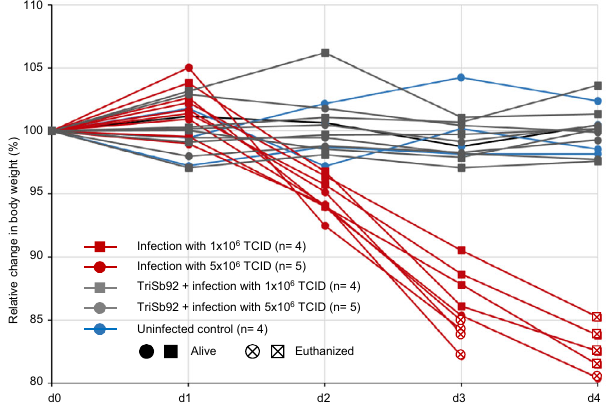
Fig. 5 | TriSb92can protect froma lethal challenge withmouse-adaptedSARS- CoV-2. Body weight development of Balb/c mice that were infected with 1×10 6 or 5×10 6 PFU of the pathogenic SARS-CoV-2 strain maVie16 following intranasal administration TriSb92 (25 μ g of per nostril; red lines and symbols) or the same volume of saline buffer (grey lines and symbols) 1h earlier, as indicated. Four control mice received similar mock treatment but no TriSb92 or virus (blue lines and symbols). The experiment was terminated at day 4 post-infection when all infected mice that had not received TriSb92 prophylaxis had been euthanized because of losing 15% or more of their weight (crossed empty symbols). This experiment was performed once. Original data on mouse weight development are provided as Source Data fi